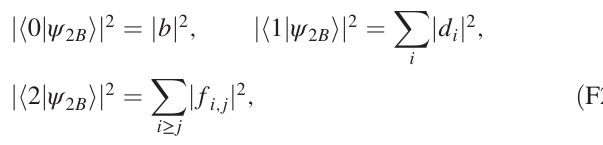
FIG. 10. Visualizing the two-photon bound state. Here, the transmon qubit is on site nine. (a) The blue dots are j d ω 7 . 6 GHz. The red dots are j d 01 ¼ ω 8 . 15 GHz. (c) The population of transmon qubit levels in the two-excitation ground state of H 01 ¼